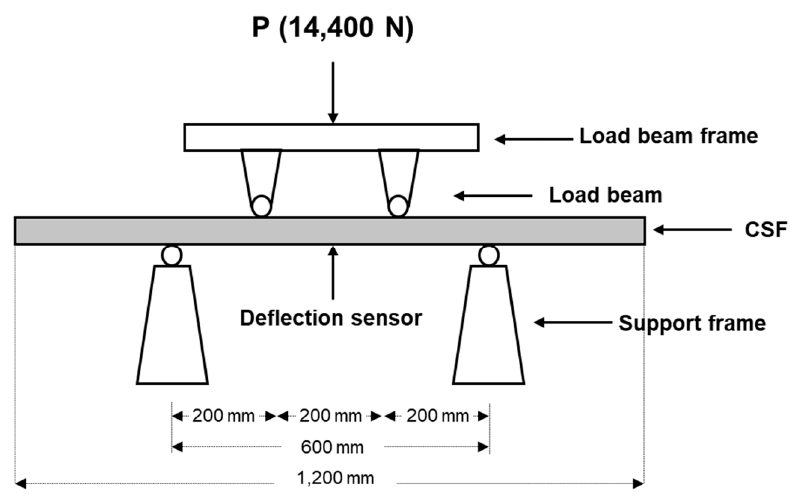
Figure 10. KS F 8006 (standard loading method for concrete form in Korea).